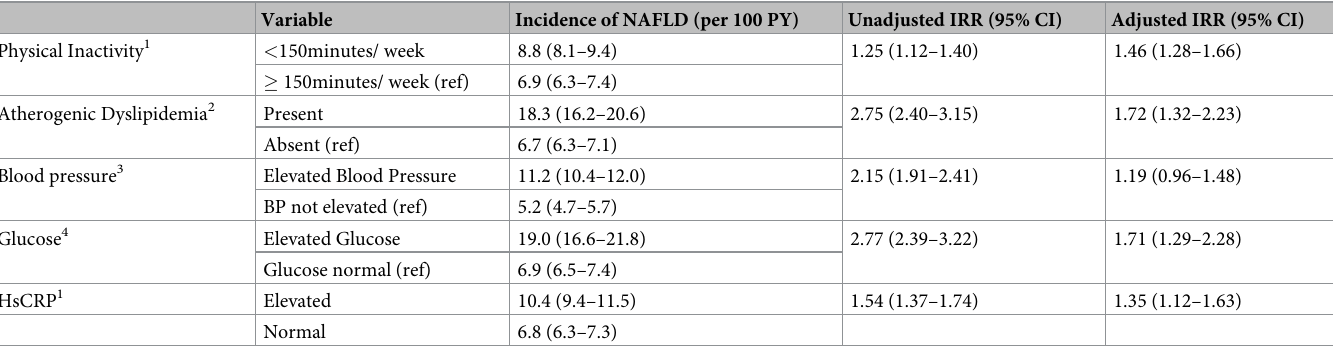
Table 3. Cardiometabolic disorders and the risk of NAFLD.